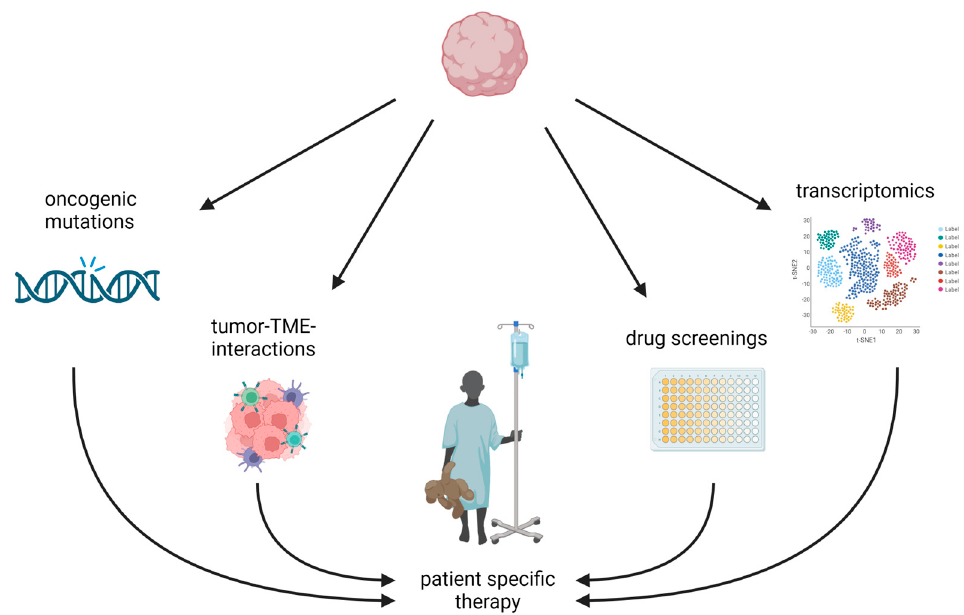
Figure 3. Broad possibilities for organoid applications pave the way to precision medicine. From left to right, latest technologies help uncover neurodevelopmental effects of oncogenic mutations, tumor–TME interactions, drug screenings, and transcriptomics and can drive the development of patient-specific therapies. Abbreviations: TME: tumor microenvironment. Created with BioRender.com (accessed on 7 November 2022).